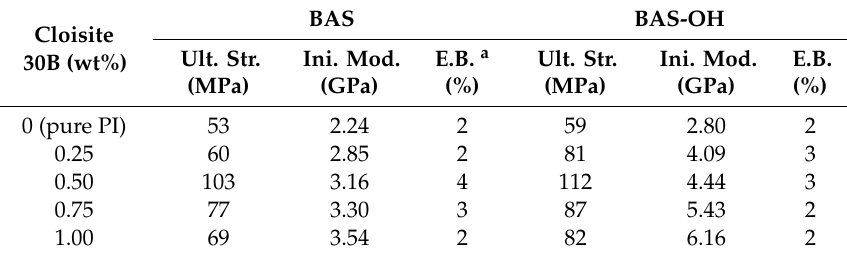
Table 3. Tensile properties of PI hybrid films with various organoclay